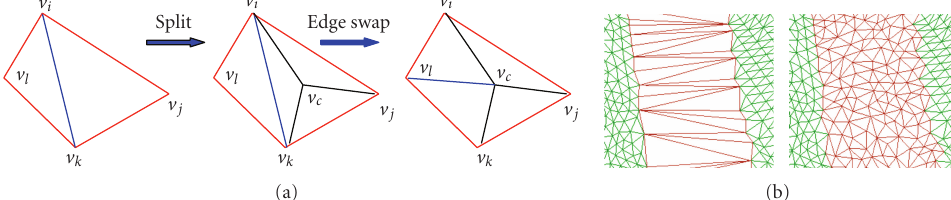
Figure 10: (a) Refinement and optimization mechanism. (b) Surface patch before and after being refined.